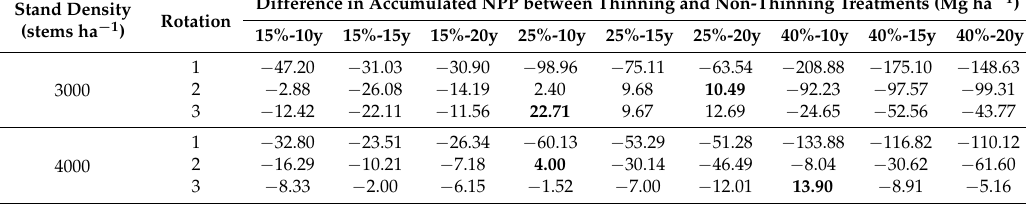
Table 2. Difference in accumulated NPP per rotation between thinning and non-thinning treatments. Positive values mean that the accumulated NPP in a rotation increased due to management compared with the non-thinning treatment. Maximum values in bold.